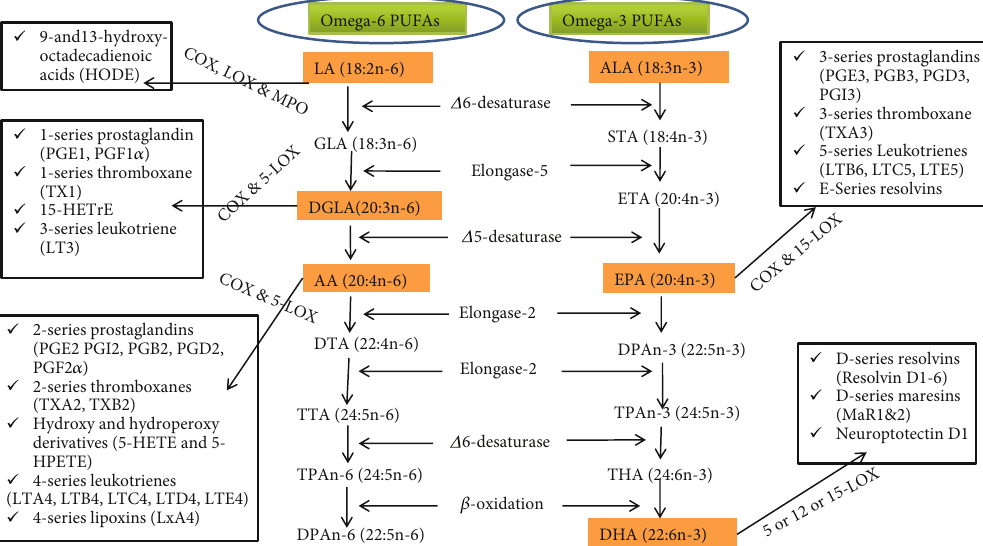
Figure 3: Biosynthesis of Omega-3 and Omega-6 PUFAs is shown at the center. The oxidative metabolism of LA, DGLA, AA, EPA, and DHA into their respective lipid mediators through oxygenase enzymes is also shown in the right and left sides. COX: cyclooxygenase; LOX: lipoxygenase; MPO: myeloperoxidase [19, 33, 48,